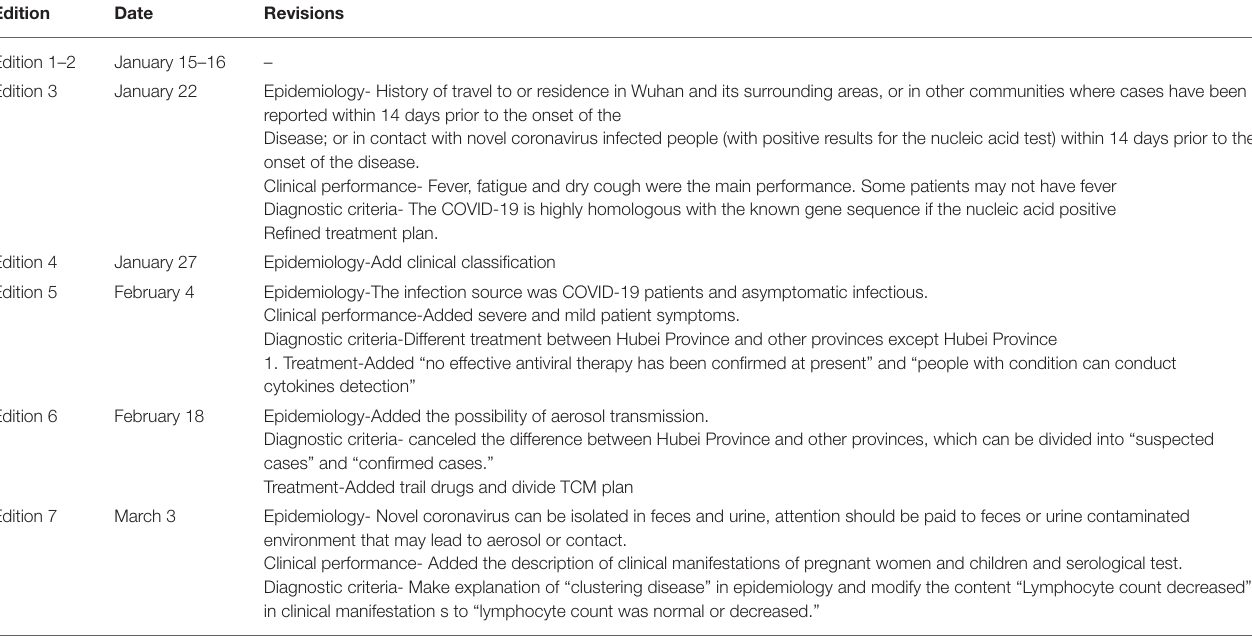
TABLE 2 | Comparisons of seven editions of Diagnosis and treatment Protocol for